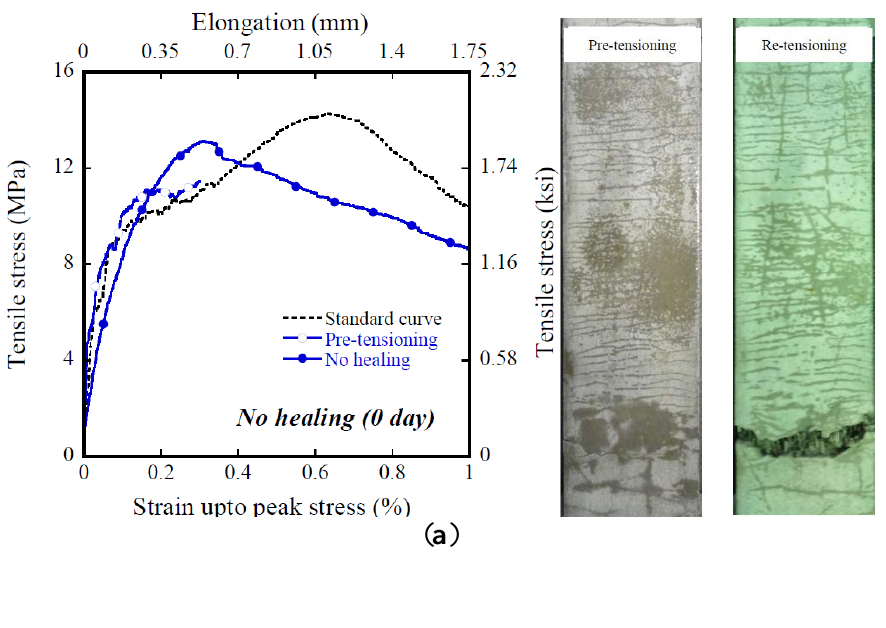
Figure 12. Tensile stress–strain curve of HPFRCCs using T-fiber after healing. ( a ) No healing (0 day); ( b ) after 3 days; ( c ) after 7 days; ( d ) after 14